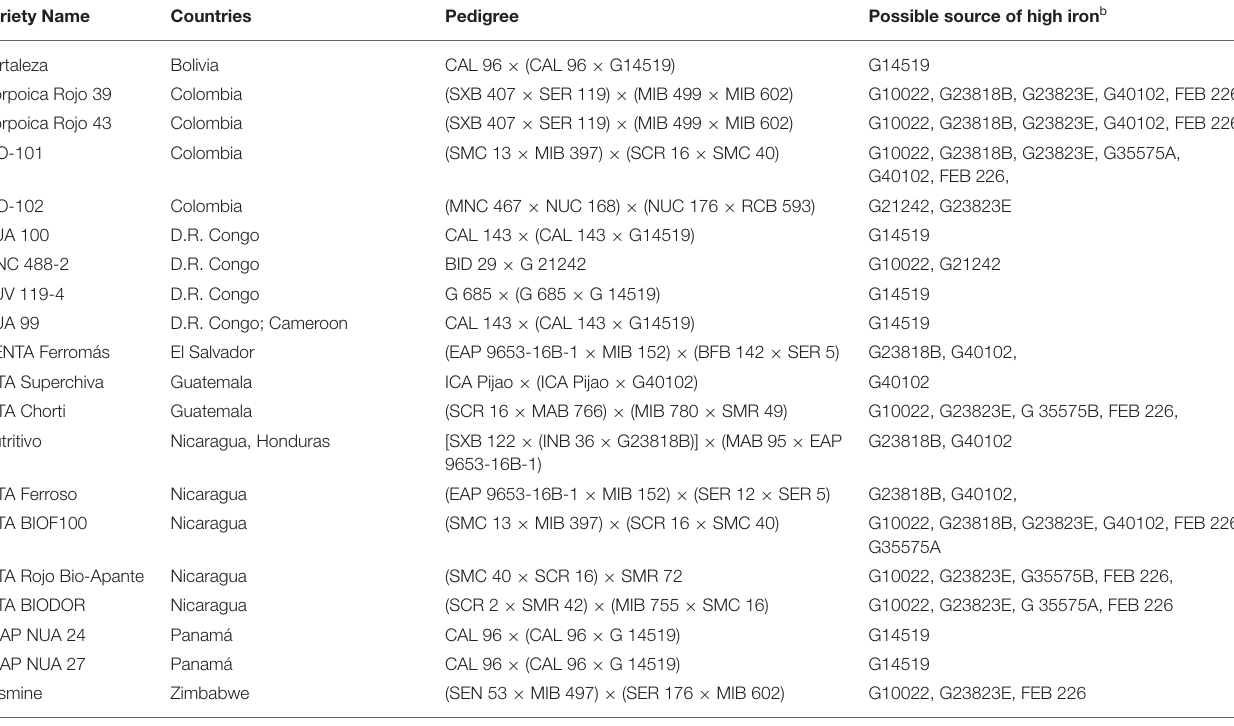
TABLE 1 | Some high iron bean varieties in different countries and diversity of parental sources of the high iron trait in development of varieties a . Variety